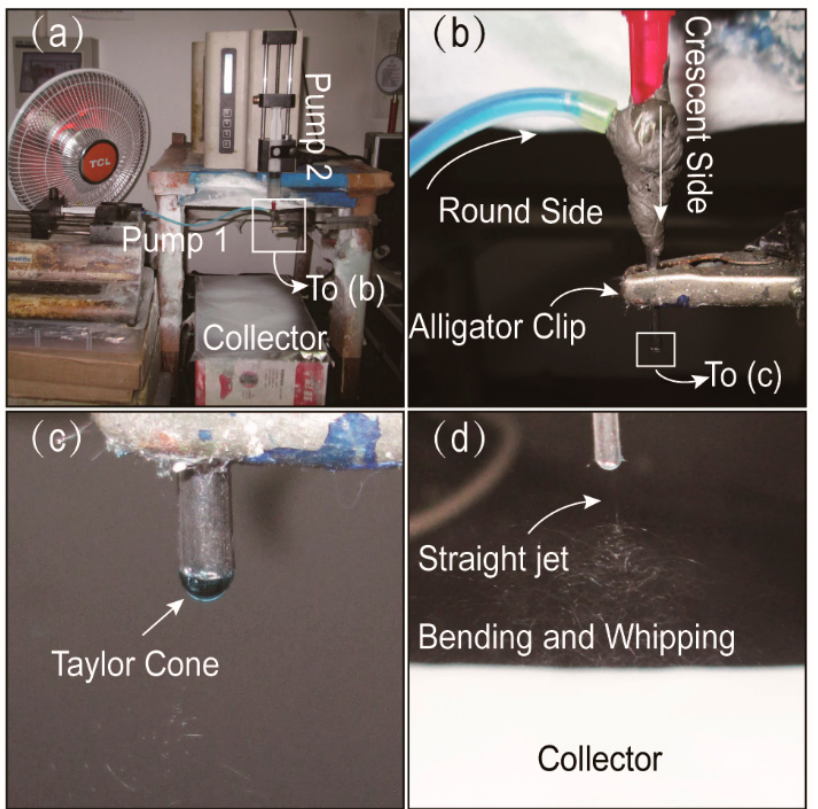
Figure 2. Observations of the side-by-side electrospinning: ( a ) the home-made side-by-side electrospinning system; ( b ) the connection of spinneret with two working fluids and power supply; ( c ) compound Taylor cone (12 kV); ( d ) typical fluid jet trajectory (12 kV).